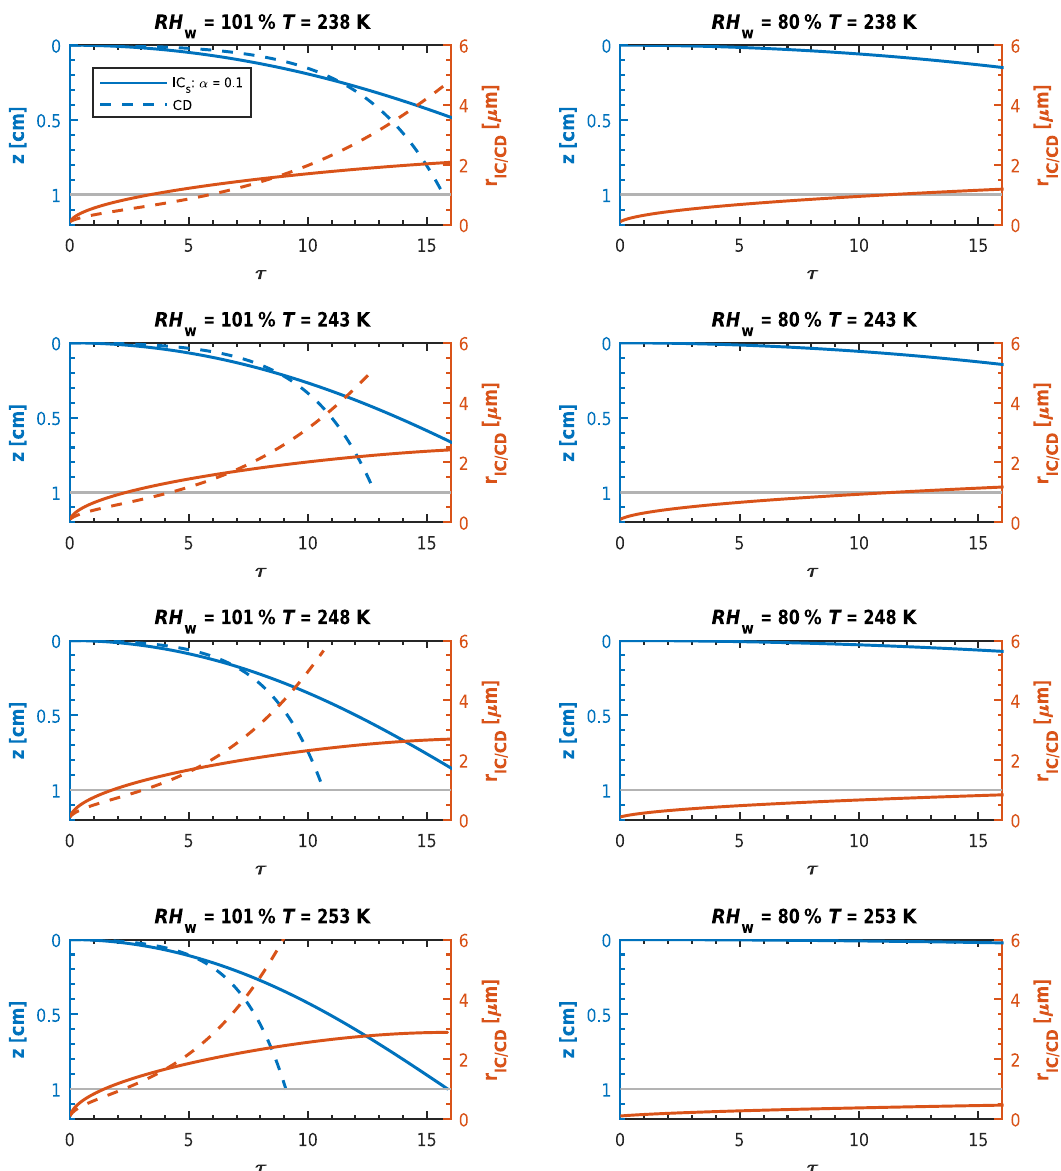
Figure D4. Expected diffusional growth and gravitational settling of spherical ice crystals (solid) and cloud droplets (dashed) for MPC temperatures, having an initial diameter of 200nm. Symbols and reference lines as in Fig.